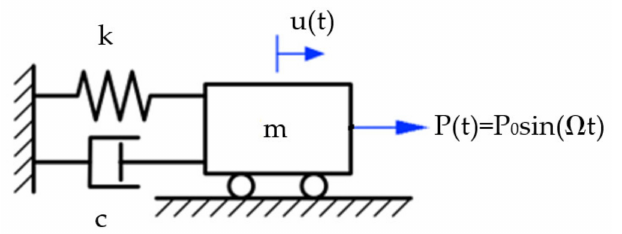
Figure 1. SDOF structure subjected to dynamic load